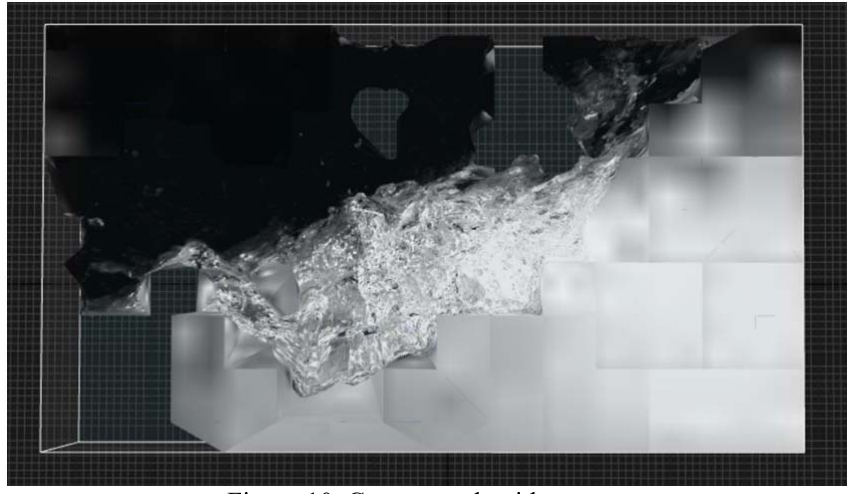
Figure 10. Coarse mesh with